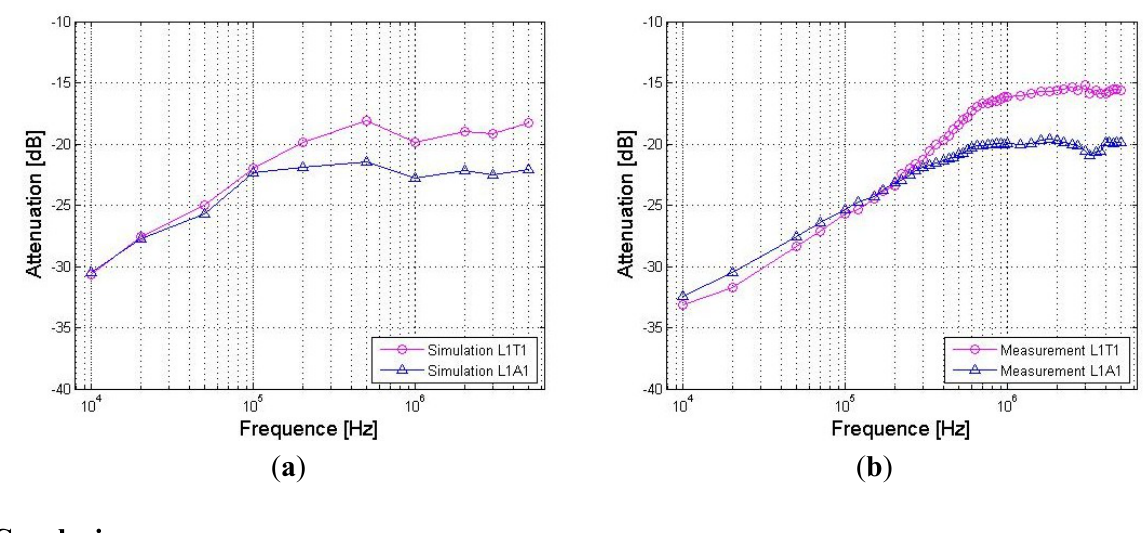
Figure 11. The influences of signal transmission distance on the simulation results ( a ) and the measurement results ( b